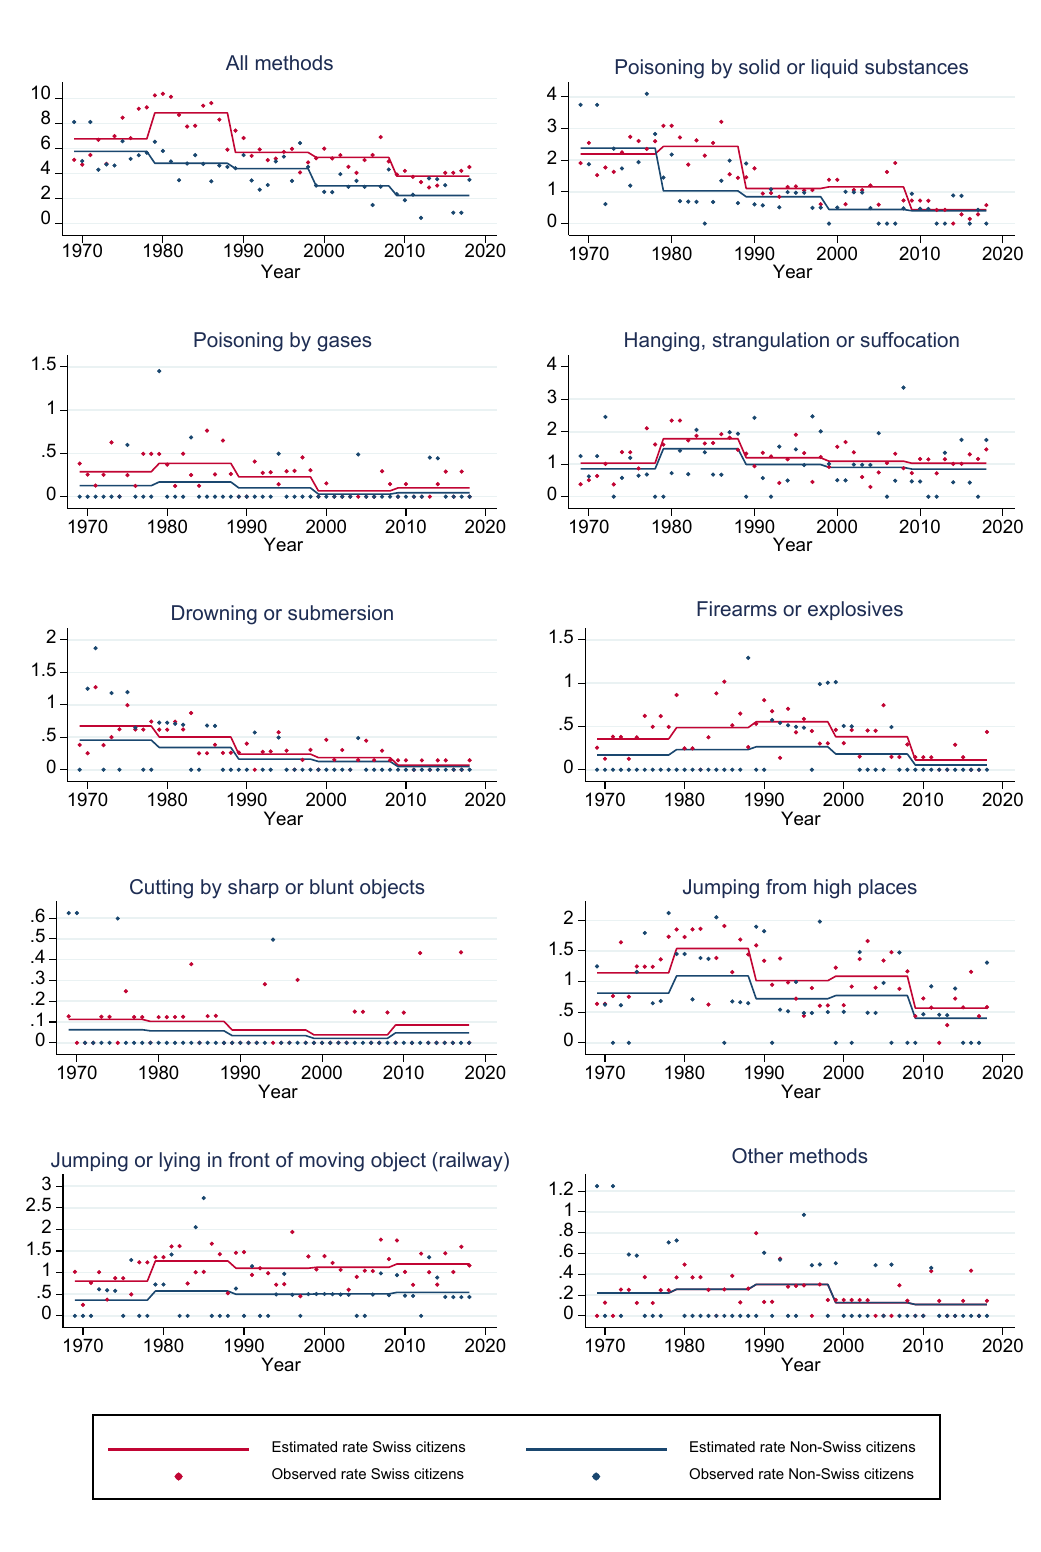
Figure S4. Rates of suicide methods per 100'000 population (person-years) in 10-29 years old women.